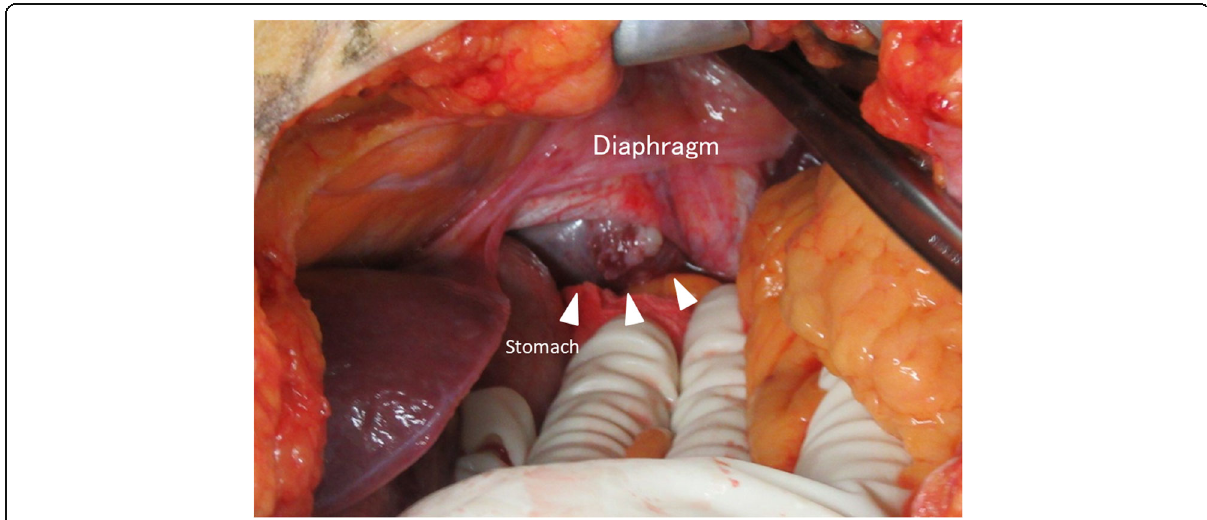
Fig. 4 Intraoperative findings. The tumor (arrowheads) can be seen arising from the stomach wall and extending to greater curvature of the gastric fundus. We approached the mediastinum by dissection of the